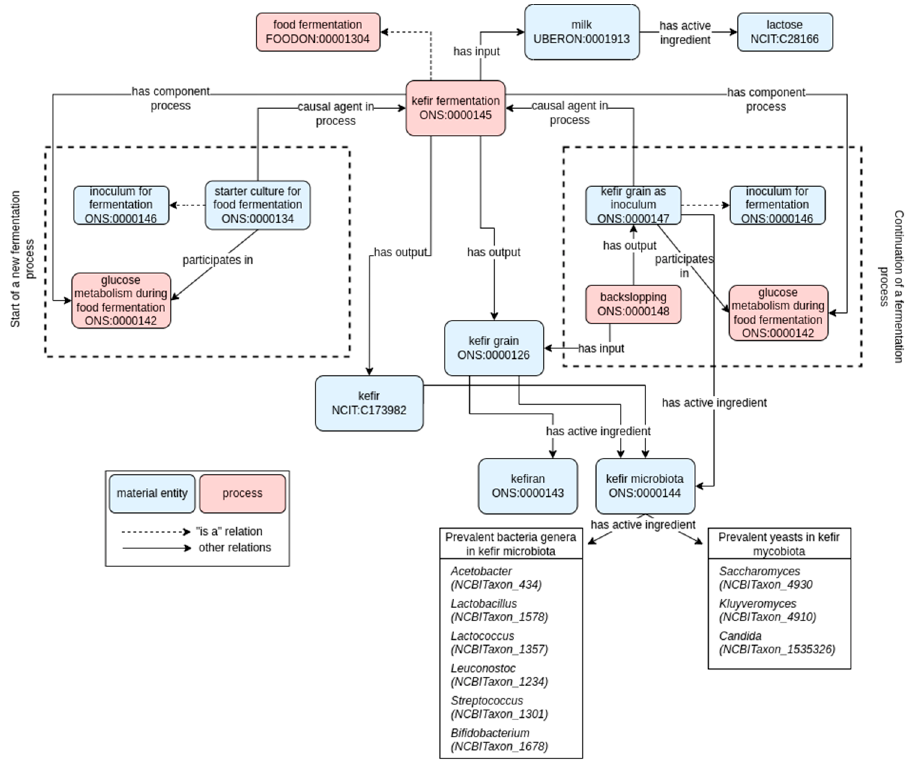
Figure 3. Ontological model of kefir fermentation. Solid arrows represent semantic relations in RO (annotated with their label), while dashed arrows represent hierarchical relationships (i.e., “is a” relation). Pink and blue rectangles refer to process or material entity, respectively. The label and the term ID (formatted as an ontology prefix followed by a number) are reported for each class. Classes are generally conceptualized to the universal level (i.e., the definition and concepts apply to any possible class instance). When suitable, instance-level concepts (indicated with white rhombus) are used to indicate a particular instance of the universal concept. For example, the prevalent bacteria genera in kefir microbiota are specific instances of the universal “bacteria” (or taxonomical subclassifications) concept (i.e., only some specific instances of the Acetobacter genus are active ingredients of the kefir microbiota, but not the entirety of the Acetobacter concept).